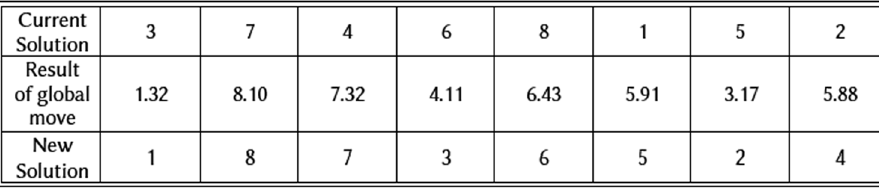
Figure 8: An example of employing the global walk on a current